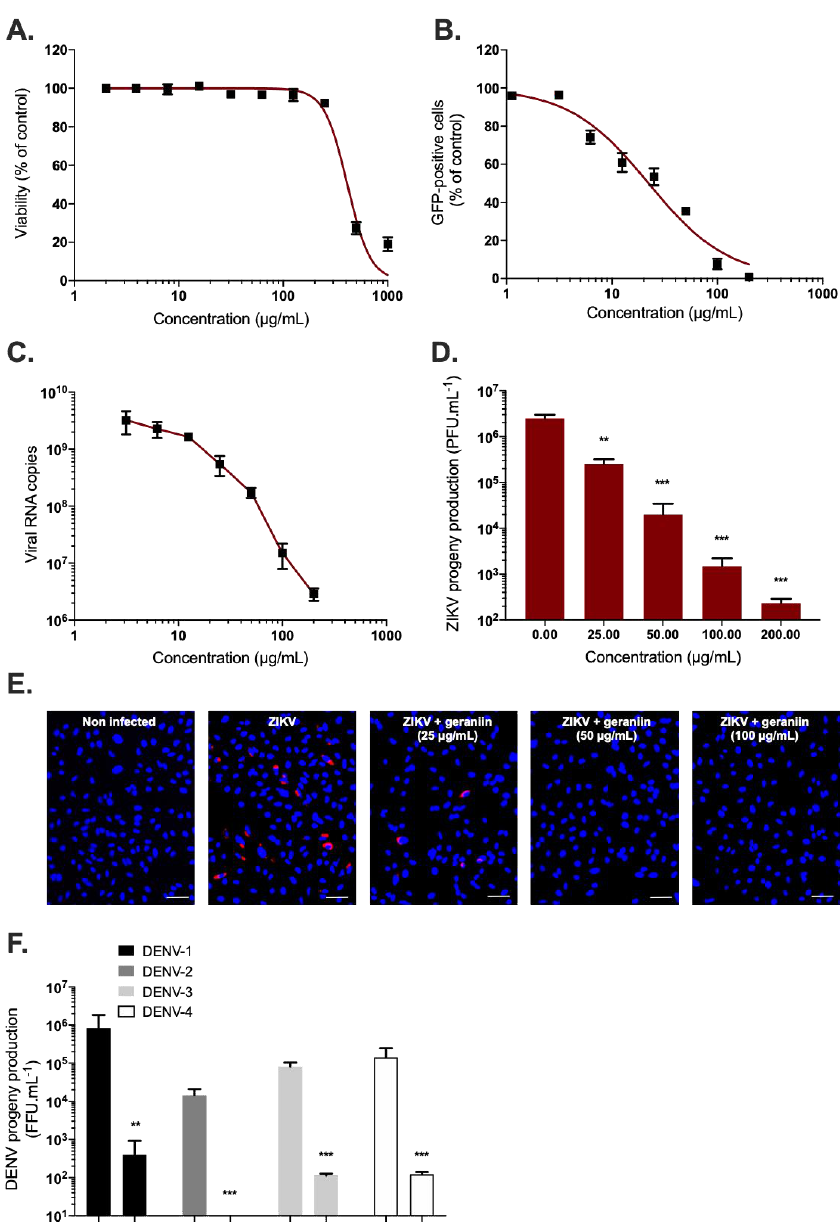
Figure 3. Geraniin inhibits ZIKV infection at non-cytotoxic concentrations. ( A ) A549 cells were incubated with two-fold serial dilutions (1000 to 2 µ g / mL) of geraniin for 72 h. Cell viability was evaluated using an MTT assay. ( B ) A549 cells were infected with ZIKV GFP at MOI of 1 in presence of di ff erent concentrations (200, 100, 50, 25, 12.5, 6.25, 3.125, and 1.125 µ g / mL) of geraniin. Flow cytometric analysis of GFP fluorescence was performed 24 h post infection. A549 cells were infected with ZIKV-PF13 at MOI of 2 and continuously incubated with increasing concentrations of geraniin. ( C ) The amount of viral genomic RNA in ZIKV-PF13-infected A549 cells was determined by RT-qPCR. ( D ) ZIKV progeny production was quantified by plaque-forming assay in presence of di ff erent concentrations of geraniin (200, 100, 50, and 25 µ g / mL). The results shown are means ± SD of four independent experiments and are expressed as relative value compared to untreated infected cells. ** p <0.01; *** p <0.001, **** p <0.0001, n.s. = not significant (E) Immunofluorescence analysis of viral protein expression in ZIKV-PF13-infected A549 cells. The ZIKV (red) and nuclei (blue) were